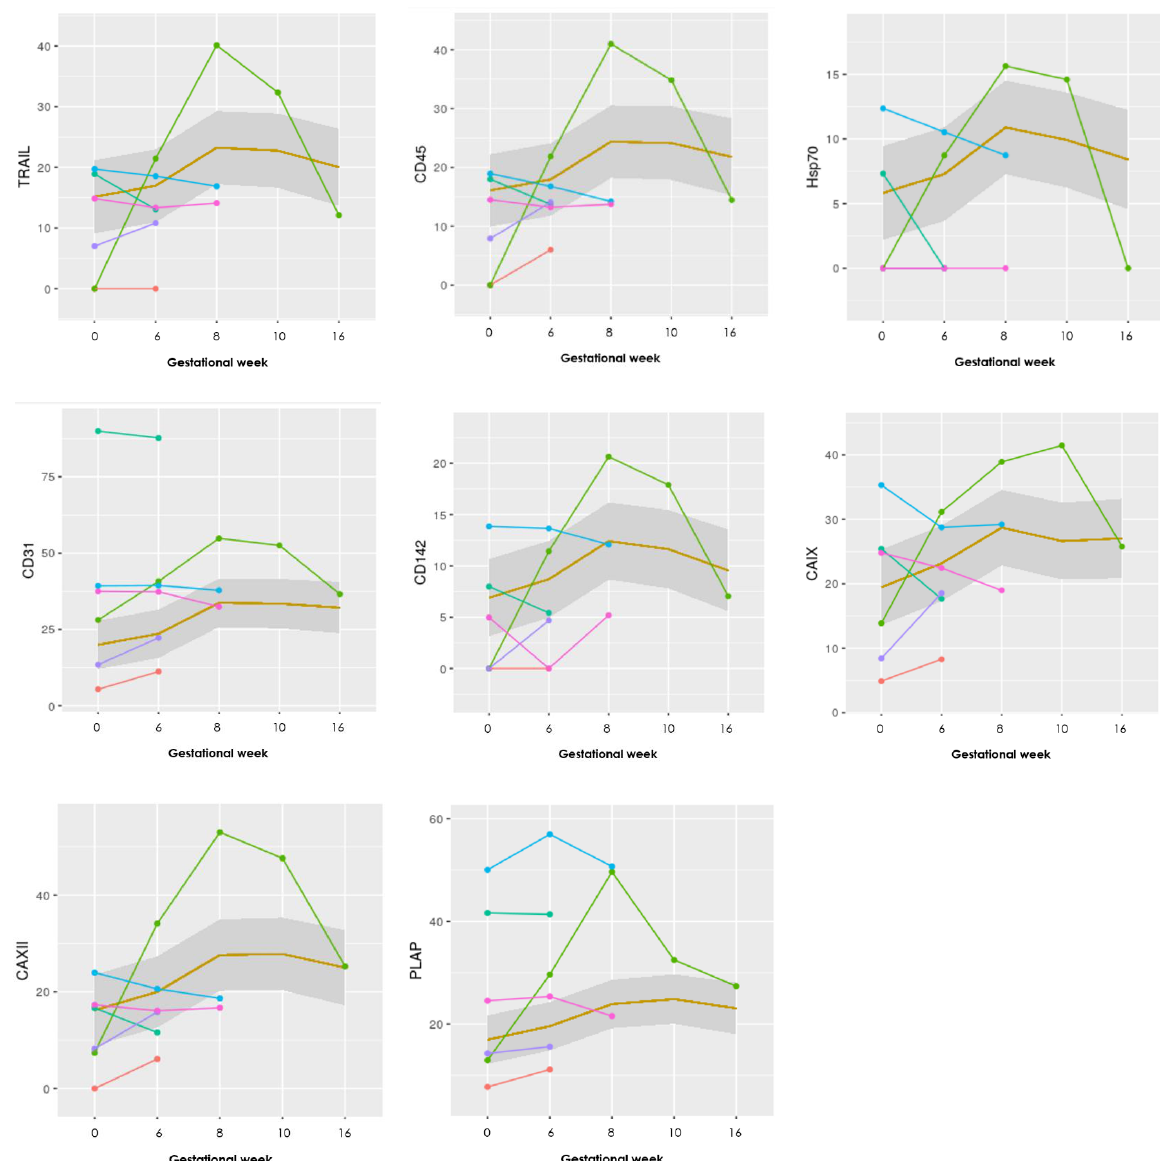
Figure A1. Graphs showing the progression of all 17 EV markers examined in the EV array. The LB group ( n = 25) is illustrated as a mean within the grey box, whereas the PL group ( n = 6) is individually visualized with six different colors. Gestational week is depicted on the x-axis and absolute levels of the antibody marker along the y-axis.